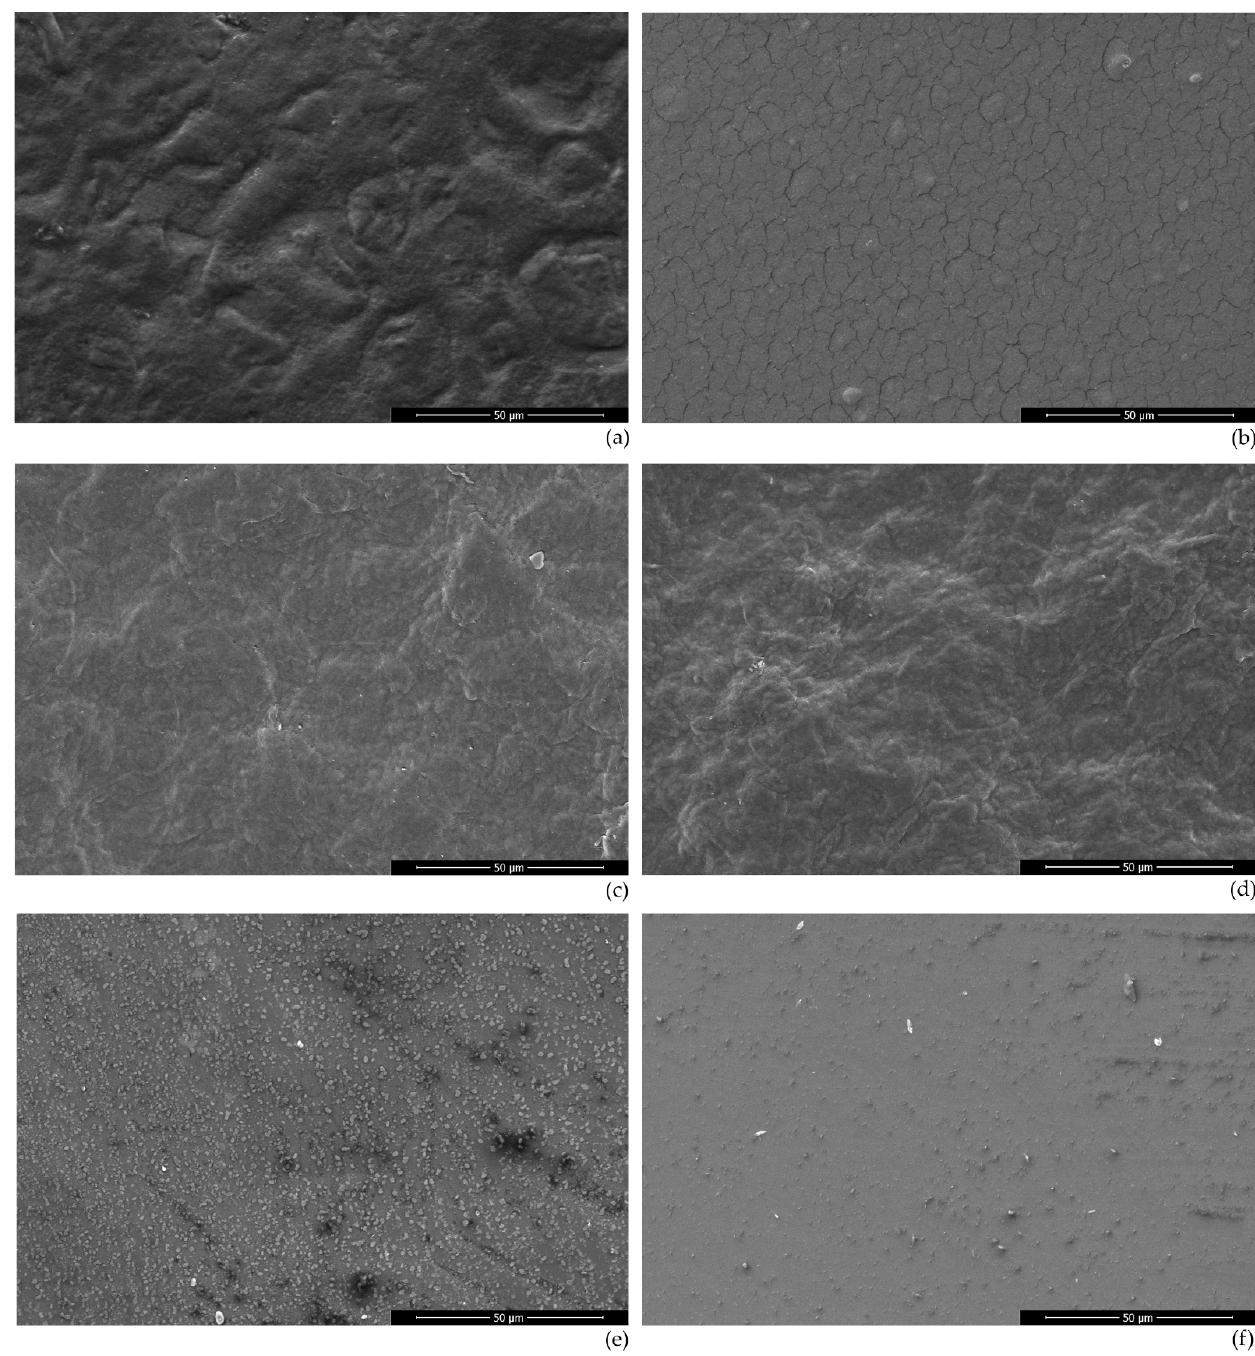
Figure 2. Scanning electronic micrographs of: ( a ) untreated starch film, ( b ) plasma-treated starch film (20 min at 50 Hz), ( c ) untreated bacterial cellulose film, ( d ) plasma-treated bacterial cellulose film (20 min at 900 Hz), ( e ) untreated gelatin film, and ( f ) plasma-treated gelatin film (20 min at 900 Hz).